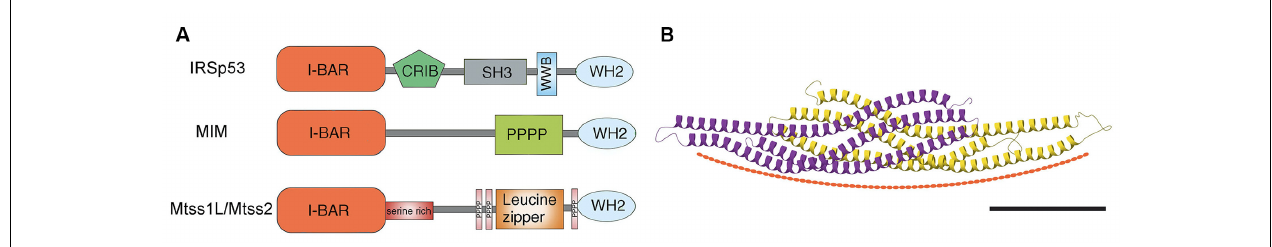
FIGURE 1 | (A) Schematic of domain structures of mammalian I-BAR domain proteins. I-BAR: I-BAR domain, WH2: WH2 domain, SH3: SH3 domain, PPPP: proline-rich region, Serine rich: serine-rich region, CRIB: Cdc42- and Rac-interactive binding domain, and WWB: WW binding domain. Modified from Sistig et al. (2017). (B) Structural and curvature-inducing activity of the I-BAR domain. Shown is an X-ray crystal structure of Mtss2 with each monomer color-coded. Scale bar: 5 nm. Modified from Abou-Kheir et al.